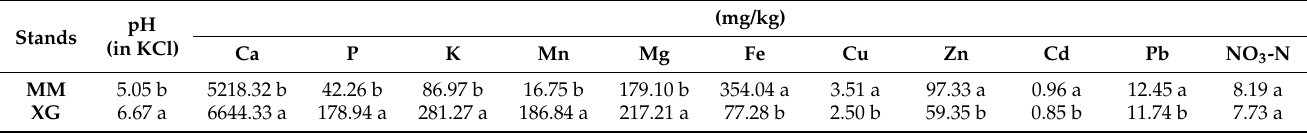
Table 1. The content of available macroelements and heavy metals as well as the pH in soil samples from the Molinia meadows (MM) and xerothermic grasslands (XG); mean values (n = 5, ± SD) marked with different letters differ significantly according to a Mann–Whitney test at p ≤ 0.05.